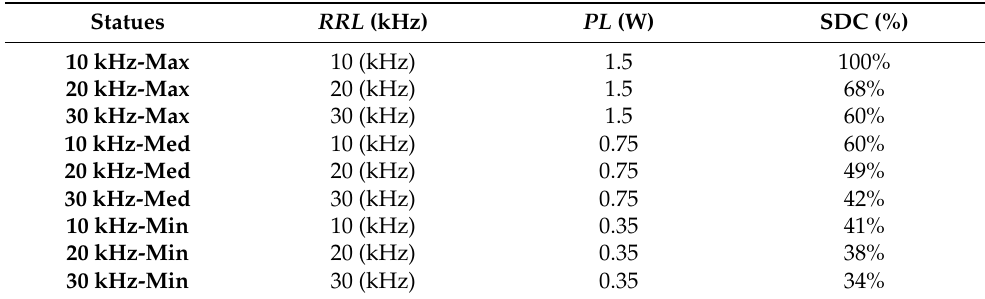
Part 2: Nine points with the same laser power (horizontal, dashed line in Figure 2) at three different levels (maximum (Max), medium (Med) and minimum (Min)) and for three